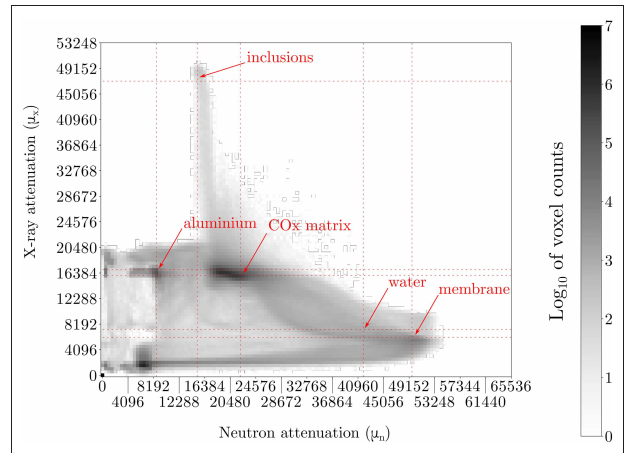
FIGURE 4 | Joint histogram of state 002, count values are presented in a log 10 scale. Intersecting values from Table 2 are highlighted.